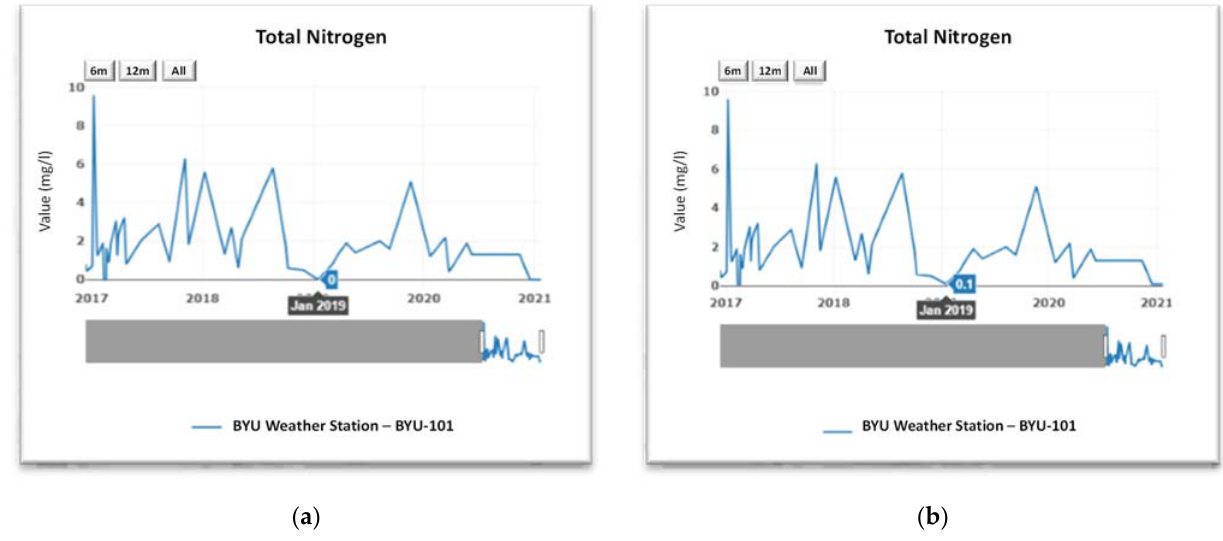
Figure 4. Timeseries for Total Nitrogen at BYU-101 station. Data January 2019: ( a ) the minimum value equal to 0; ( b ) the minimum value equal to reporting limit.